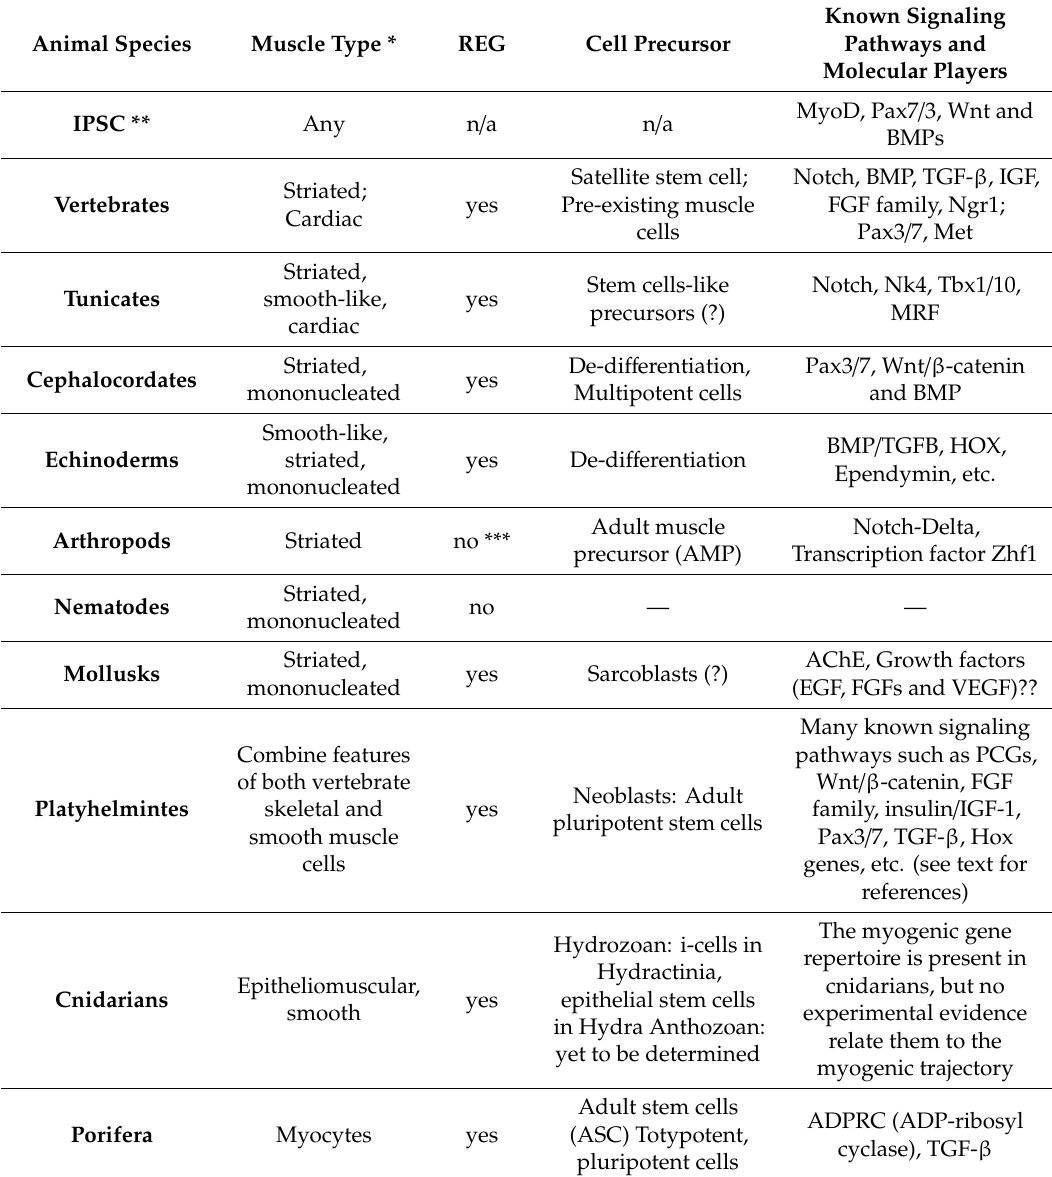
Table 1. Overview of muscle cell types and regenerative potentials of the animals treated in this review. * Muscle type discussed in this review in the context of regeneration, ** Induced pluripotent stem cells, can be derived from various species, *** Mostly